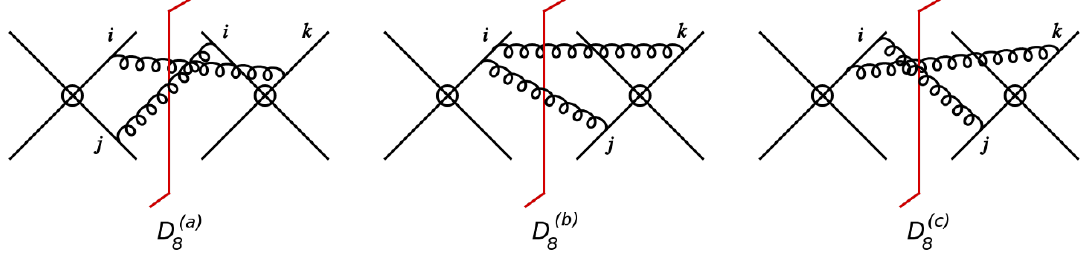
Figure 6 . Three-Wilson-line, double-cut diagrams required for the calculation of the NNLO soft function.